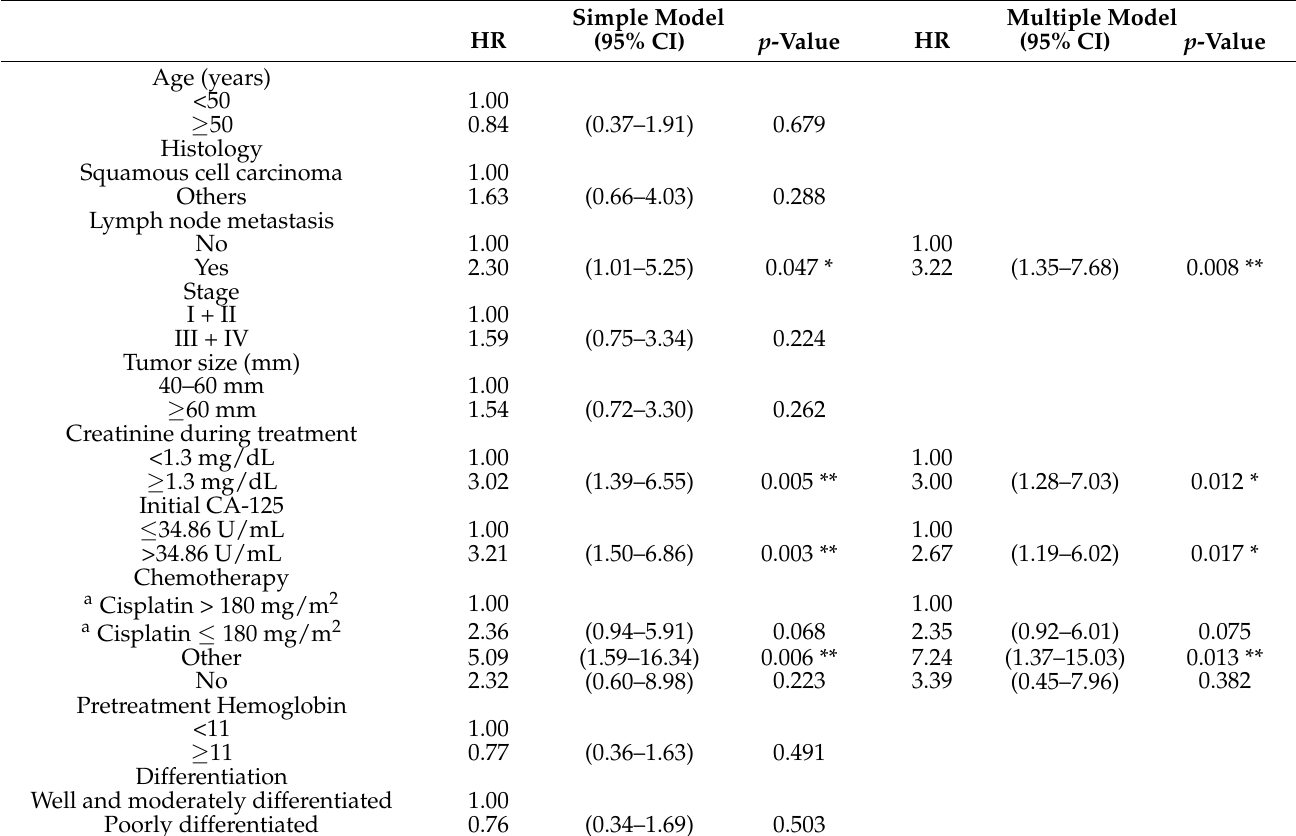
Table 3. Univariate and multivariate analyses of recurrence .